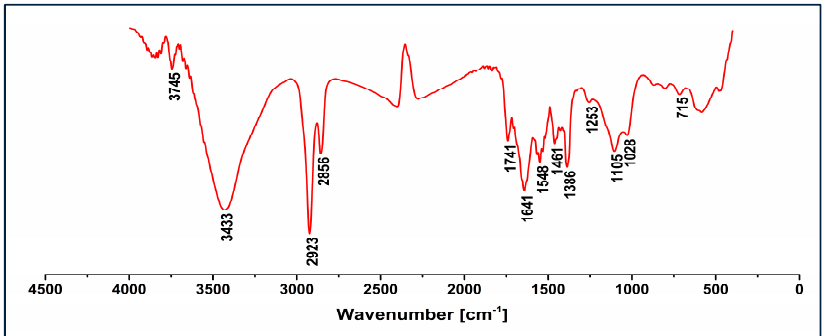
Figure 2. IR spectrum of multi walled carbon nanotubes.